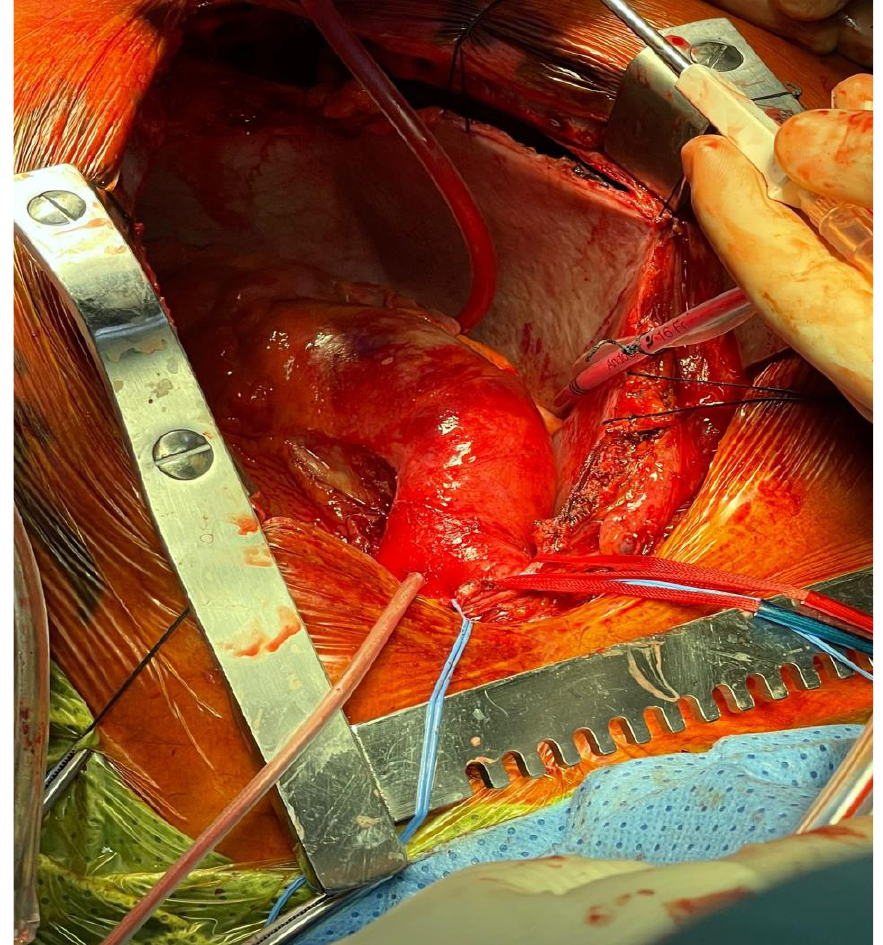
Figure 2. Real picture of type A aortic dissection surgical repair after sternotomy. Among patients who have undergone surgical procedure, 30 day mortality is 9.2% overall, 18.3% for emergent dissections or ruptures and 5.5% for aneurysm repair. The long-term survival for 30 day survivors was 86.9%, 77.6%, 52.1%, 38.3% and 26.7% at 5, 10, 20, 30 and 40 years, respectively [11]. Data derived from International registry